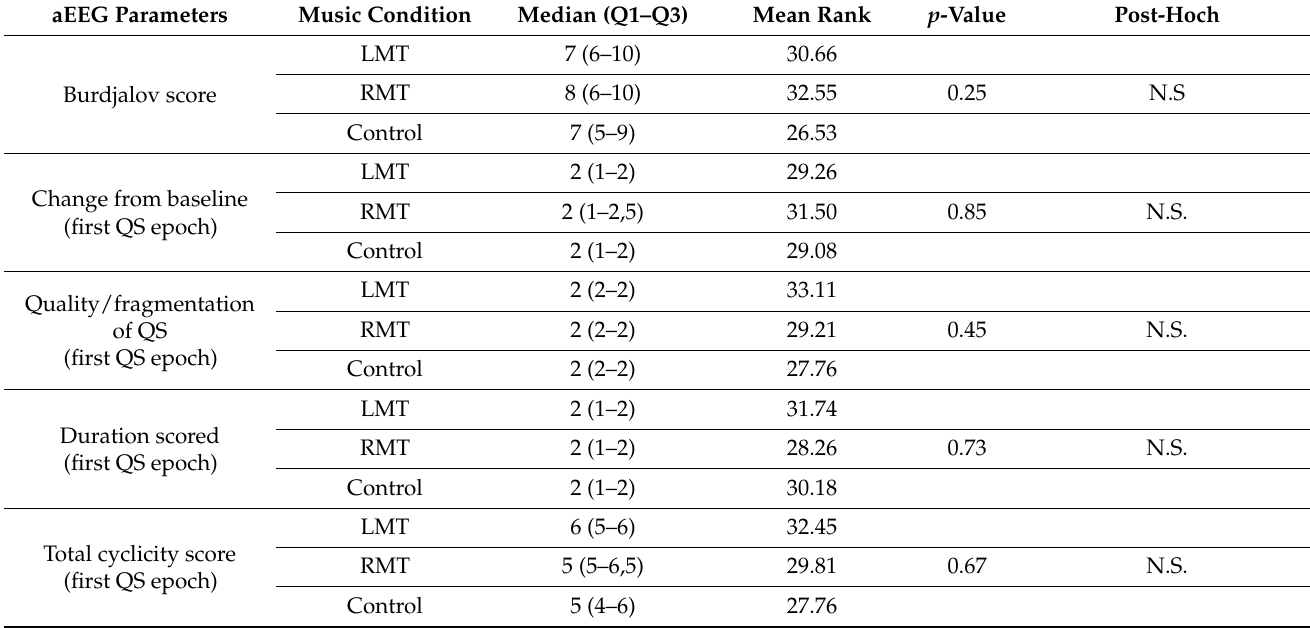
Table 2. The aEEG analysis between the